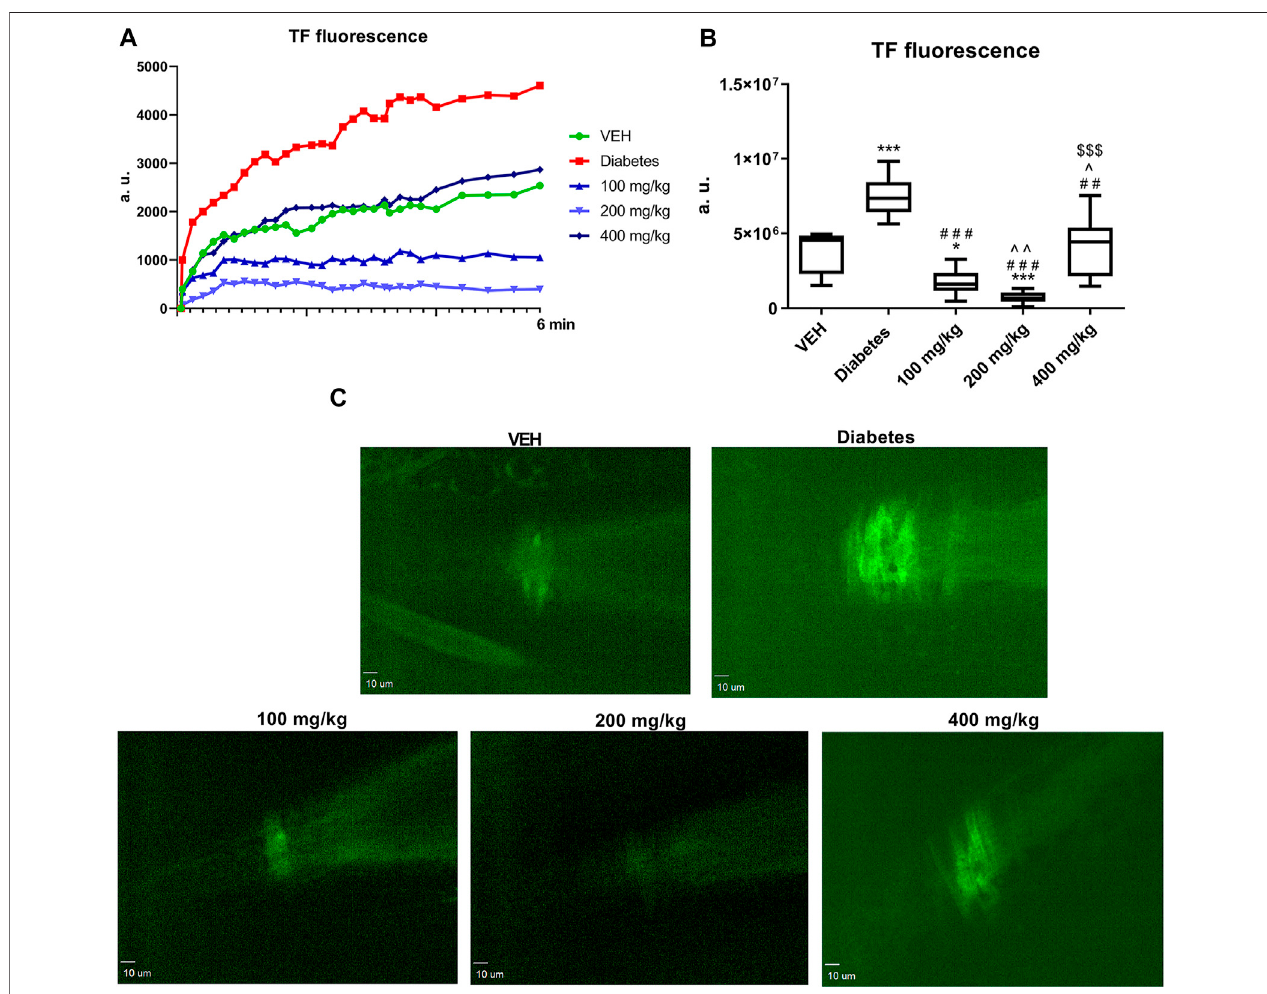
FIGURE8| ChangesinTF fl uorescenceatthesiteofinjuryovertime.FluorescenceofTFispresentedinarbitraryunitsof fl uorescence(a.u.) (A) .TheeffectofTEon TF expression (B) . Representative confocal microscopy images of TF expression. Bar (cid:2) 10 µm (C) . * p < 0.05, *** p < 0.001 vs. VEH; ## p < 0.01, ### p < 0.001 vs. Diabetes; ^ p < 0.05, ^^ p < 0.01 vs. 100 mg/kg; $$$ p < 0.001 vs. 200 mg/kg; n (cid:2) 7 – 9. Data are shown as median (interquartile range).